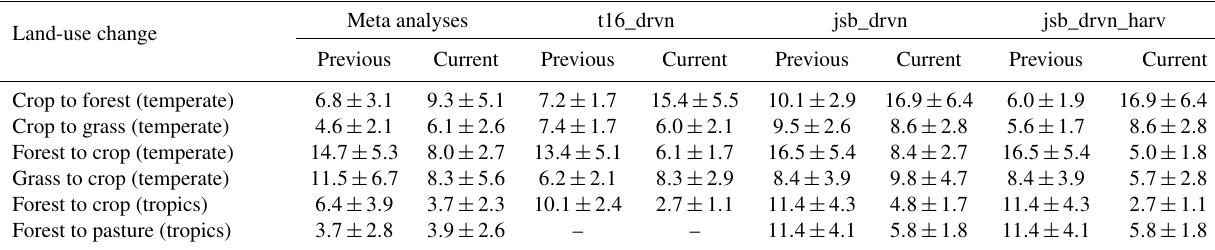
Table 3. Mean simulated equilibrium soil C densities at the model depth (100cm) and the mean soil C in the meta-analyses in kgCm − 2 for previous and current land use in the different LUCs and simulations ( ± SD). The meta-analyses soil C densities represent the mean over sites with different measuring